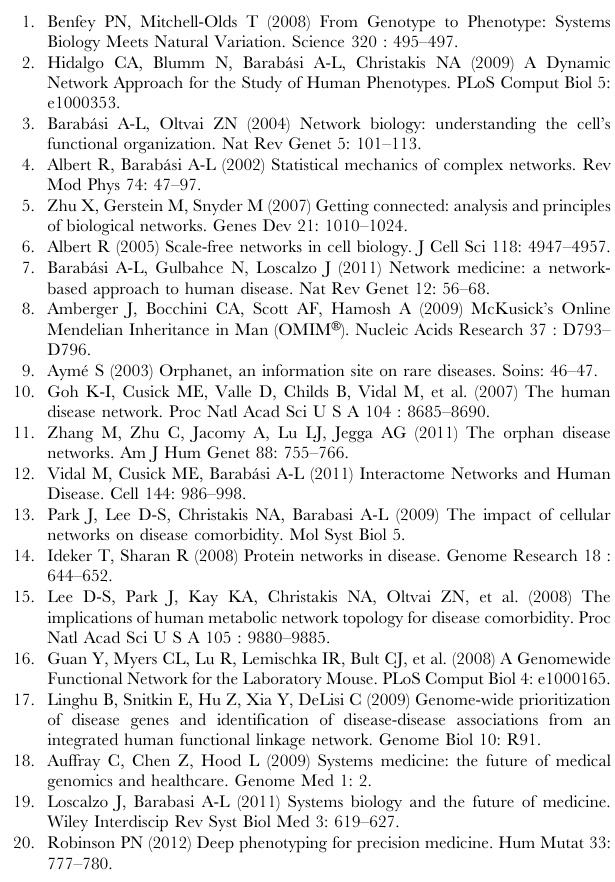
Figure S2 Spearman correlation between the number of pathophenotypes per gene and the average pathopheno- typic similarity per gene for PSGN genes. Figure S3 Graph of the pathophenotypes annotated to maple syrup urine syndrome. Parental nodes are close to the root in the human phenotype ontology and, therefore, with lower specificity. In contrast, child nodes are the most informative and specific pathological phenotypes. Table S1 Bipartite and unipartite projections of the updated version of the human diseases network. Table S2 Bipartite and unipartite projections of the updated version of the orphan disease network. Table S3 Different gene subsets in the human diseases network following proposed classification. Table S4 Different gene subsets in the orphan diseases network following proposed classification. Table S5 Different biomolecular interactomes based on physical, metabolic and functional interactions.